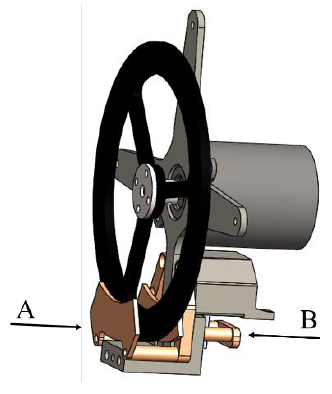
Figure 8. The braking system.